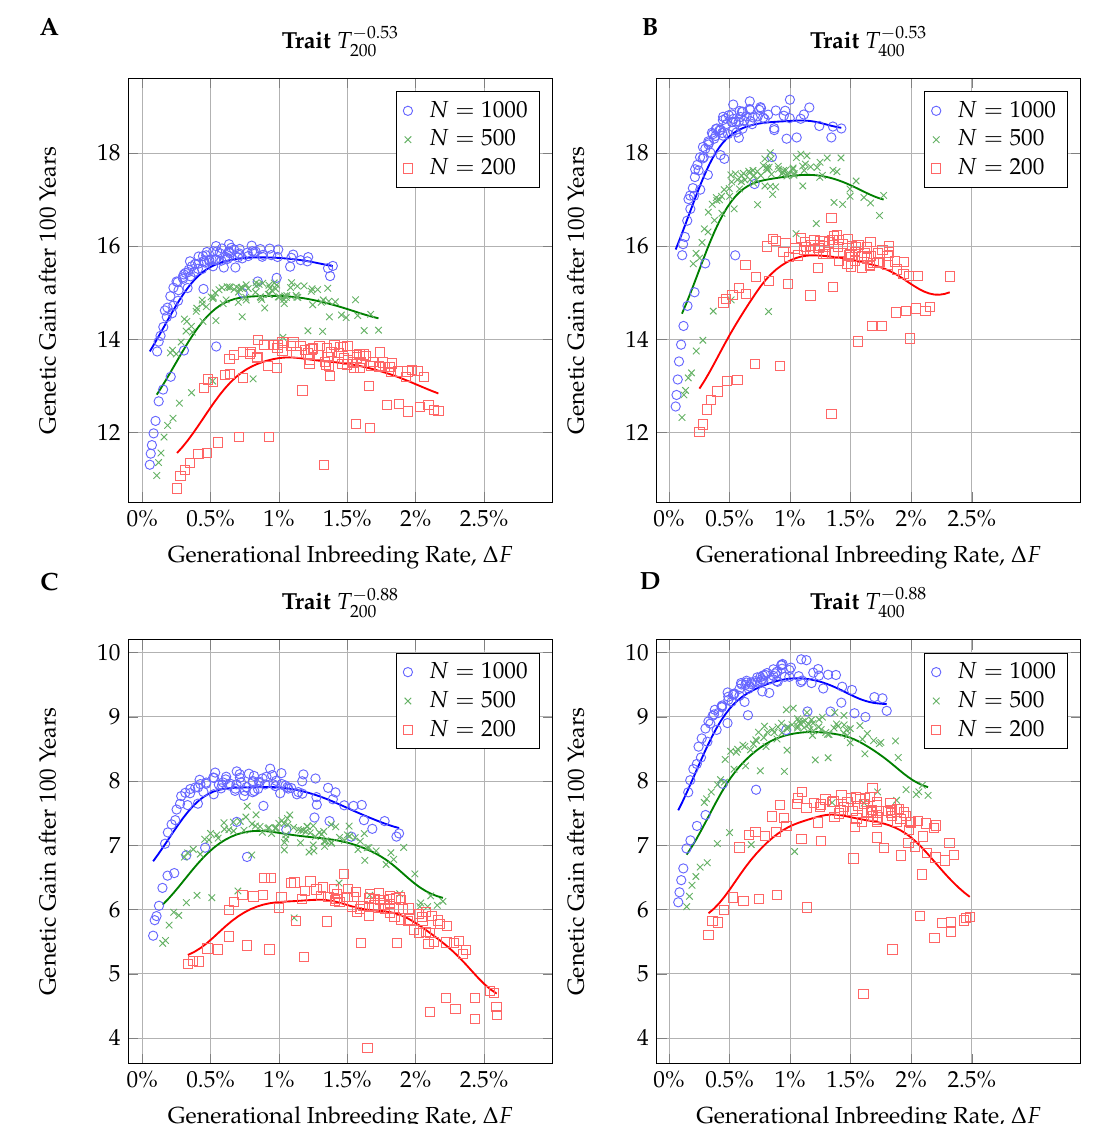
Figure 4. Scatter-plot of genetic response after 100 years vs. generational inbreeding rate. The regression curves were obtained using a Gaussian kernel with bandwidth 0.003, as they were implemented in the R package np [56,57]. Subfigures ( A – D ) represent the four simulated traits, defined by number of influential loci ( N l = 200,400) and the correlation between maternal and direct effects ( r md = − 0.53, −